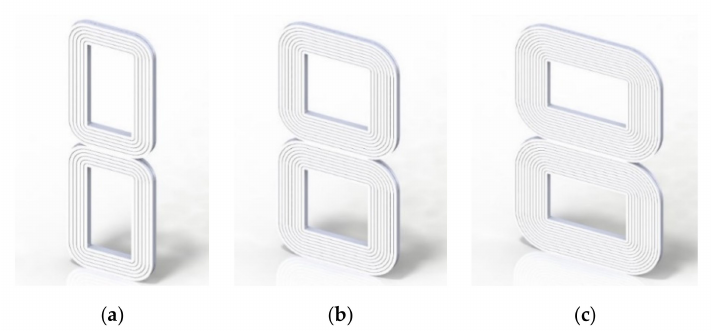
Figure 15. The variation of the lift and guidance forces at P z and P y , respectively, for the velocity v h with the change in N turn and L zc in the selected pole pitches: ( a ) τ c = ( 1/3 ) τ SCM , ( b ) τ c = ( 1/2 ) τ SCM , and ( c ) τ c = ( 2/3 ) τ SCM .